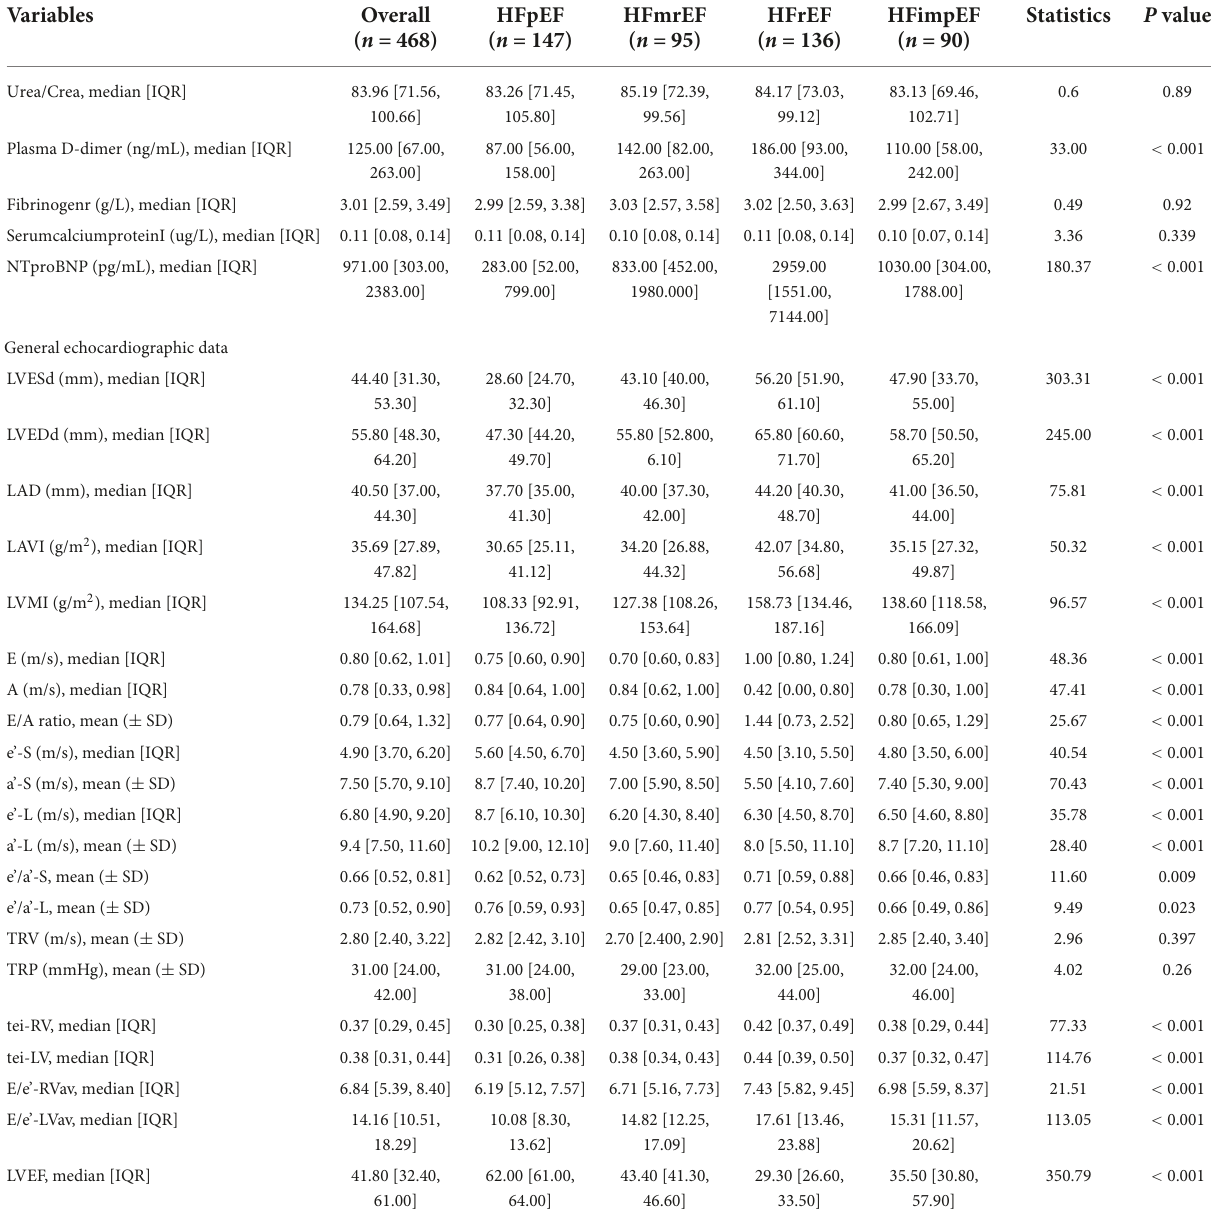
The KM survival curves and cumulative survival curves were used to compare survival times among different groups was made by log-rank test. The median survival time (LT50) for different groups. The horizontal axis of the KM survival curve represents time, and the vertical axis represents probability ( Figure 6 ).